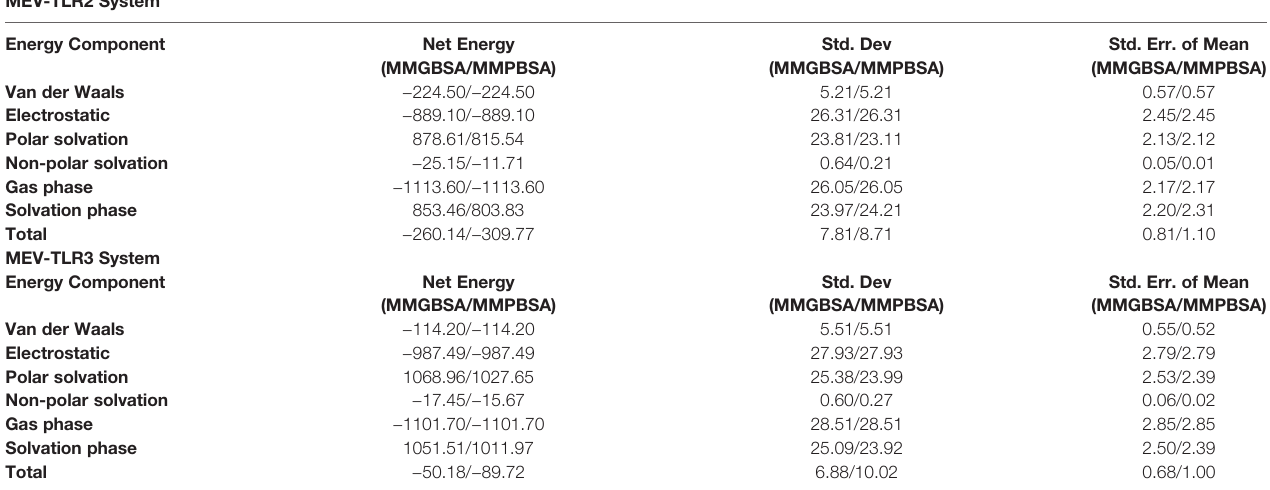
TABLE 2 | Binding free energy calculations of MEV-TLRs systems by MM-GB(PB)SA method. MEV-TLR2 System Energy Component